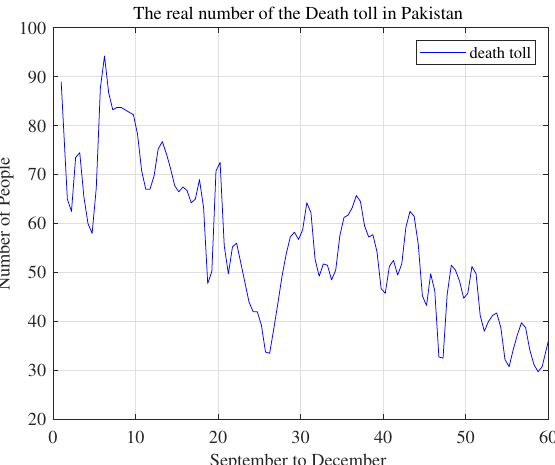
Figure 4. The red curve represents the daily statistics number of infections in Pakistan from September to December 2021.